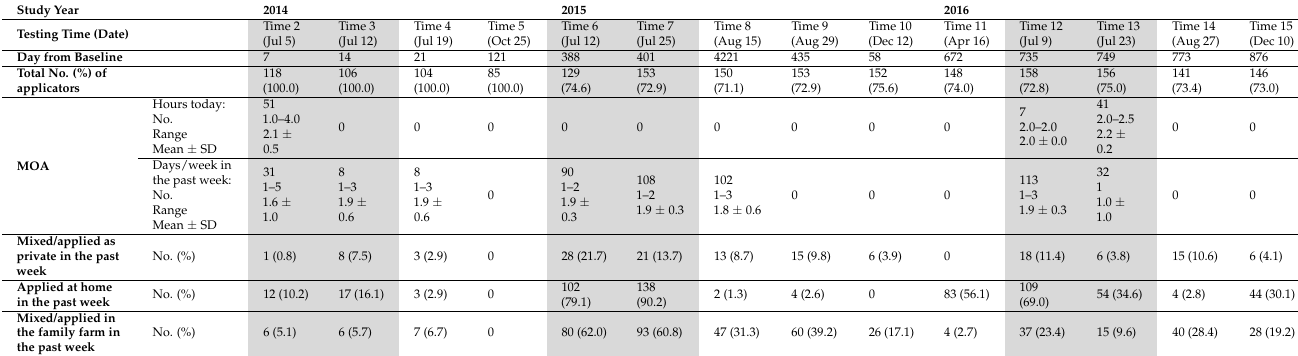
Table 2. Exposure characteristics of the pesticide applicator group at each testing timepoint across the 3 years of study (from the repeated questionnaire). Shaded areas indicate the times of CPF application. There was no collection of these data at Time